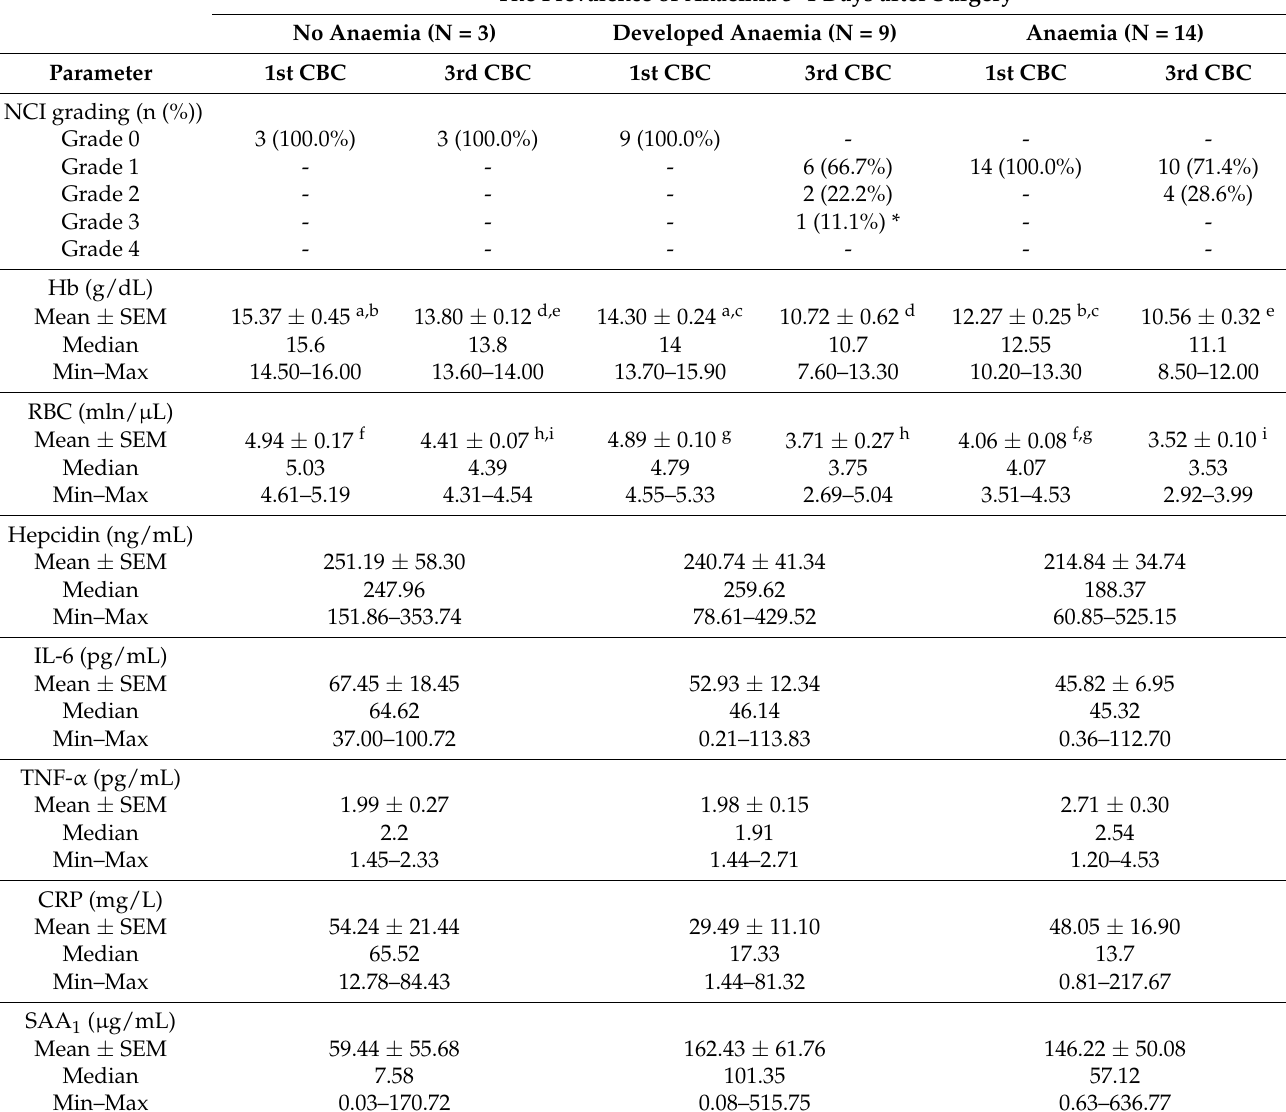
Table 6. Descriptive statistics of complete blood count parameters from the first and third complete blood count examinations, as well as hepcidin, IL-6, TNF- α , CRP, and SAA 1 levels in men with and without anaemia, and in men who developed anaemia after